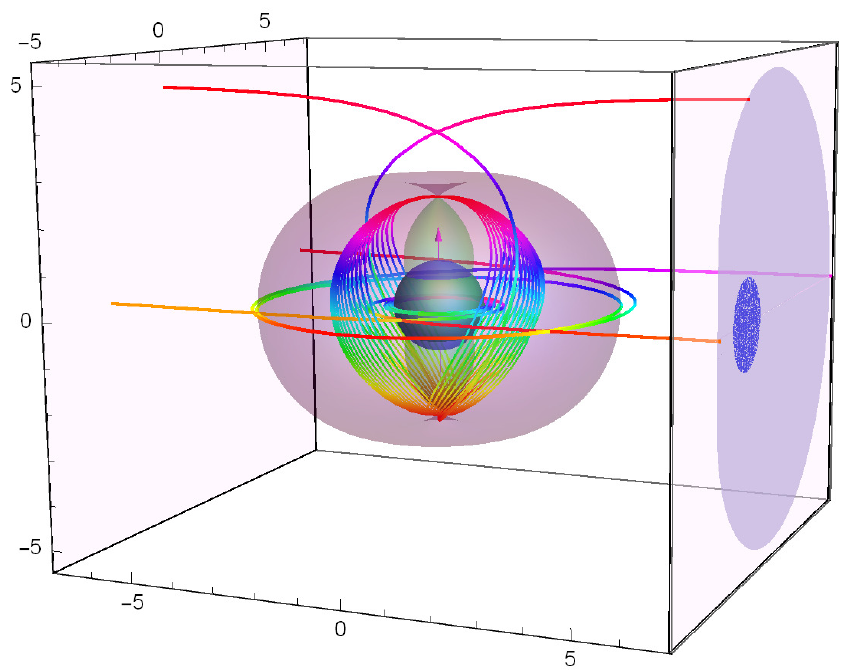
Figure 2. The classical shadow (closed magenta region) of the extreme Kerr black hole ( a = 1), highlighted by the distant luminous background and viewed by a distant observer in the black hole equatorial plane. A closed purple region is an envelope of photon spheres for photons with λ ≤ 0, while a closed green region is an envelope of photon spheres for photons with λ ≥ 0. Multicolored curves are the examples of photon trajectories, producing an outline (boundary) of the classical black hole shadow, with orbital parameters, respectively, ( λ , q ) = ( 2,0 ) —corotating skimming photon in the equatorial plane, ( λ , q ) = ( − 7,0 ) —counter-rotating photon in the equatorial plane and √ ( λ , q ) = ( 0, 2 ) —fully spherical photon orbit. A blue disk with a radius r = 1 inside the black hole shadow is the observed position of the black hole event horizon in the imaginary Euclidean space (in the absence of gravity). The magenta arrow is the black hole rotation